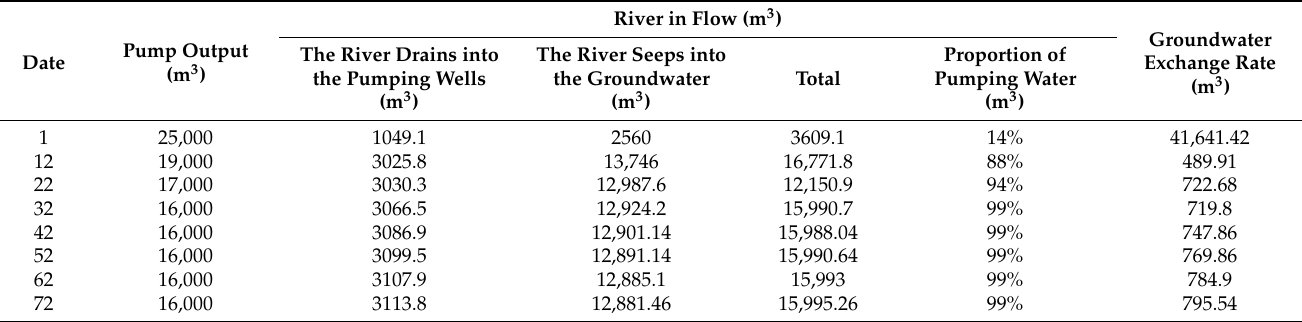
Table 5. Water balance data from a 95% typical dry